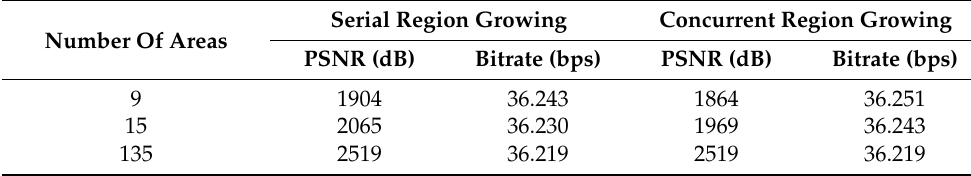
Table 6. PSNR (dB) and Bitrate (bps) for extreme number of areas.